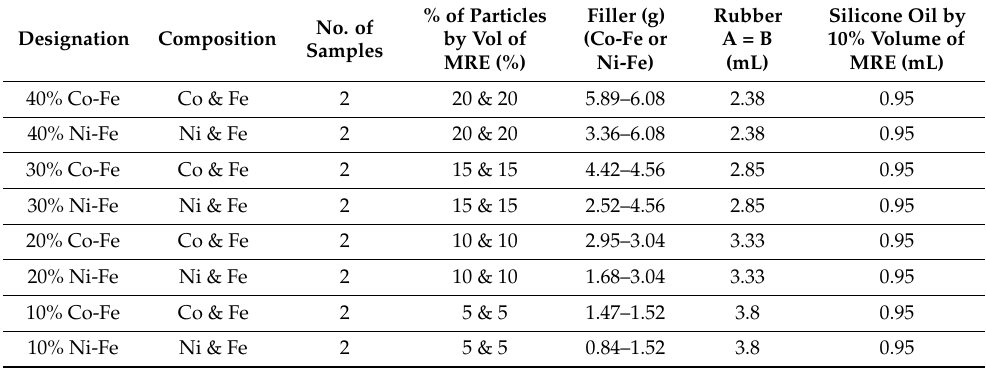
Table 1. Sample ratios and